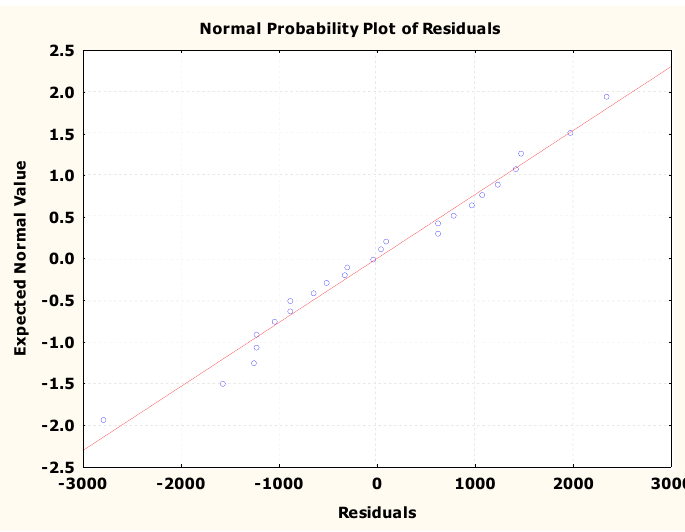
Figure 7. The normal probability plot of